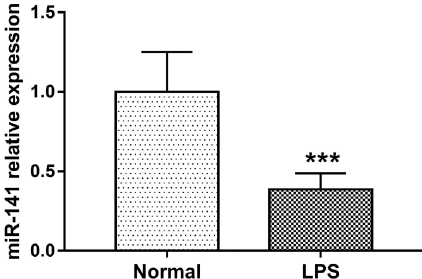
Figure 2 . Inhibited expression of miR-141 in monocytes treated with lipopolysaccharide (LPS). Data are reported as means ± SD. ***P o 0.001 ( t